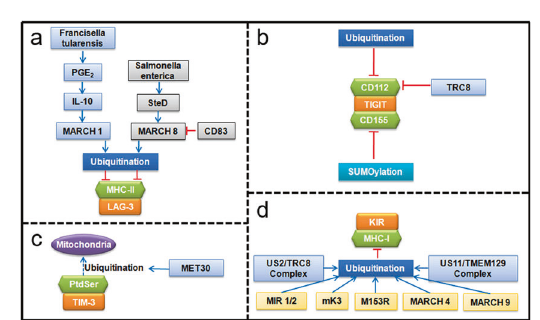
Fig. 4 Schematic diagram of the regulation of a LAG-3, b TIGIT, c TIM-3, and d KIR checkpoint pathways by modulating ubiquitina-